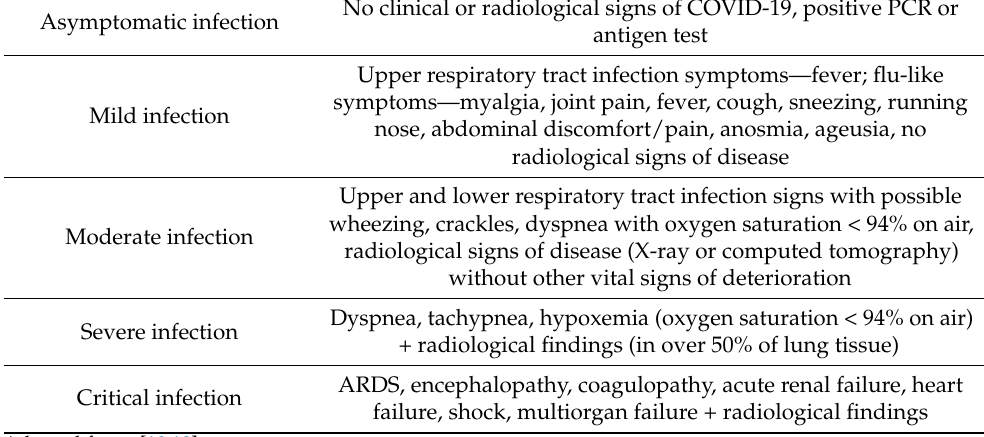
Table 2. COVID-19 clinical